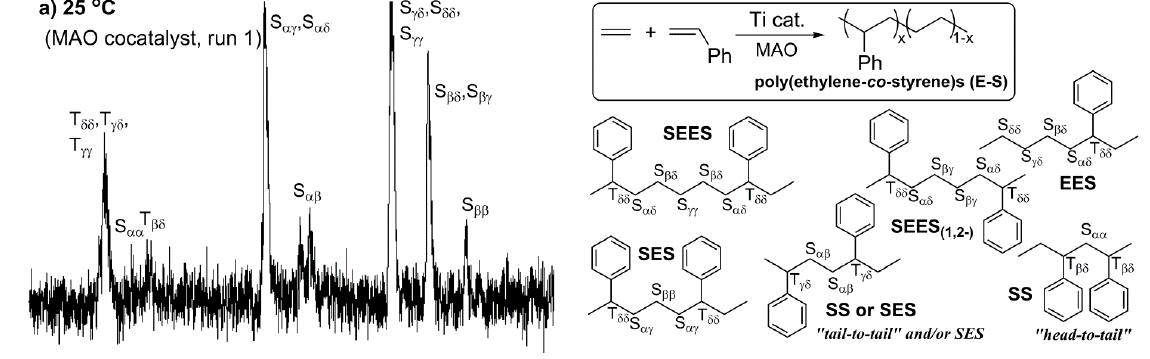
at 110 °C) for the resultant 2 ( O -2,6- i Pr C H ) ( 4 )–MAO 2 2 6 3